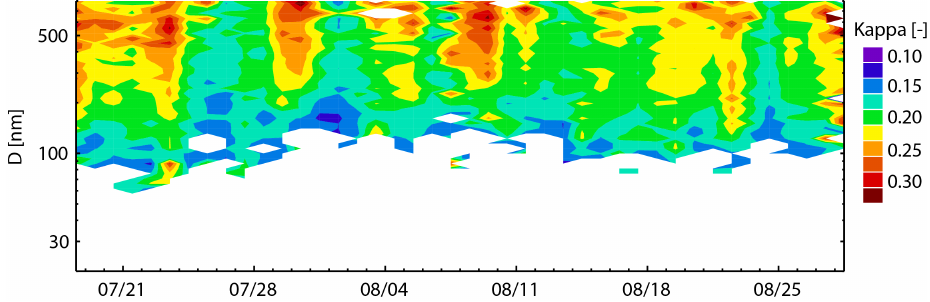
Fig. 4. Daily κ distributions calculated from AMS measured aerosol